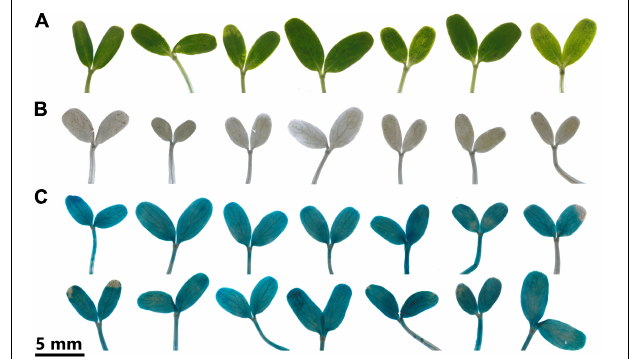
FIGURE 6 | Catharanthus roseus seedlings after transformation with A. tumefaciens . C. roseus seedlings (10-day-old) were vacuum infiltrated with A. tumefaciens lacking the vector encoding the GUS reporter at OD 600 = 0.4 (A,B) or containing the vector encoding the GUS reporter at OD 600 = 0.2 (pSB161, C). Samples were taken at 3 dpi. Seedlings (B,C) underwent histochemical GUS assay and then were destained in 70% ethanol.